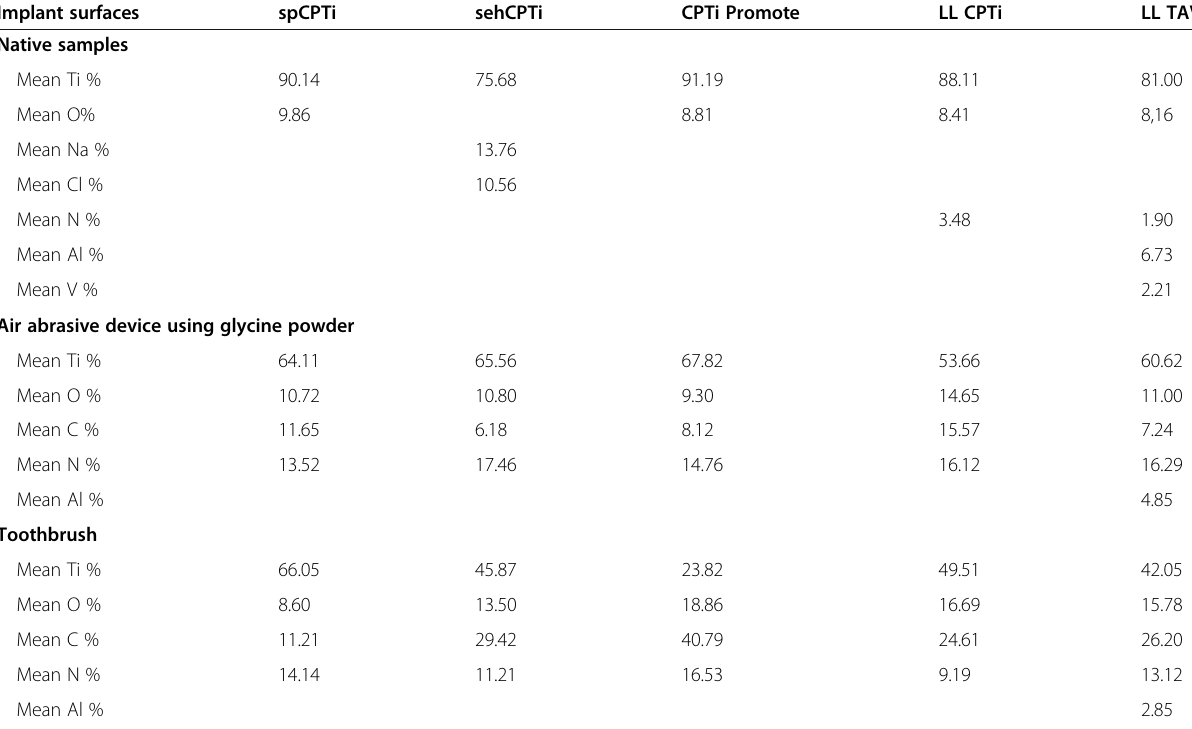
Table 4 Overview on mean weight percentages of chemical elements of the different implant surfaces without and after treatment procedures regarding the groups Implant surfaces Native samples